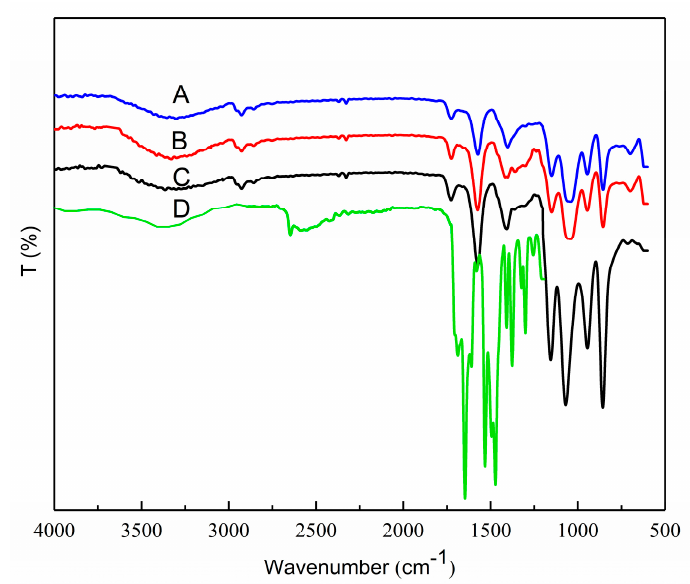
Figure 5. IR curves of inclusion complexes: OSA 0.25 –SGC–CUR—A, OSA 0.5